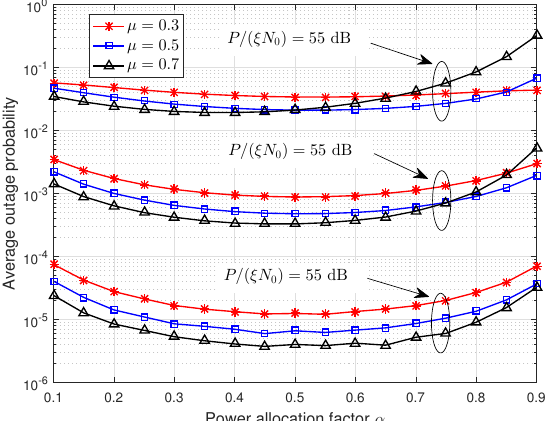
Figure 7. The effect of power allocation factor α on the average outage probability with different relay locations.